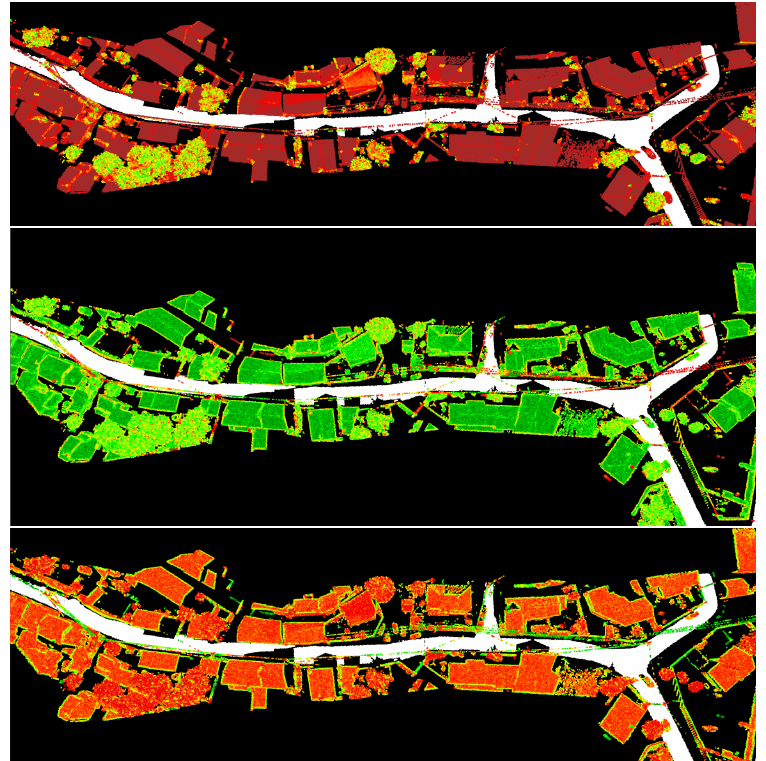
Figure 4. Eigenvalues ordered from 1 ( top ) to 3 ( bottom ) in the most detailed scale, KNN = 25. All eigenvalues are taken into account in this paper, since each one allows us to distinguish between cases of different classes (for example, for eigenvalue 1, low values indicate the class of buildings). Very strong descriptors can be obtained by aggregating all